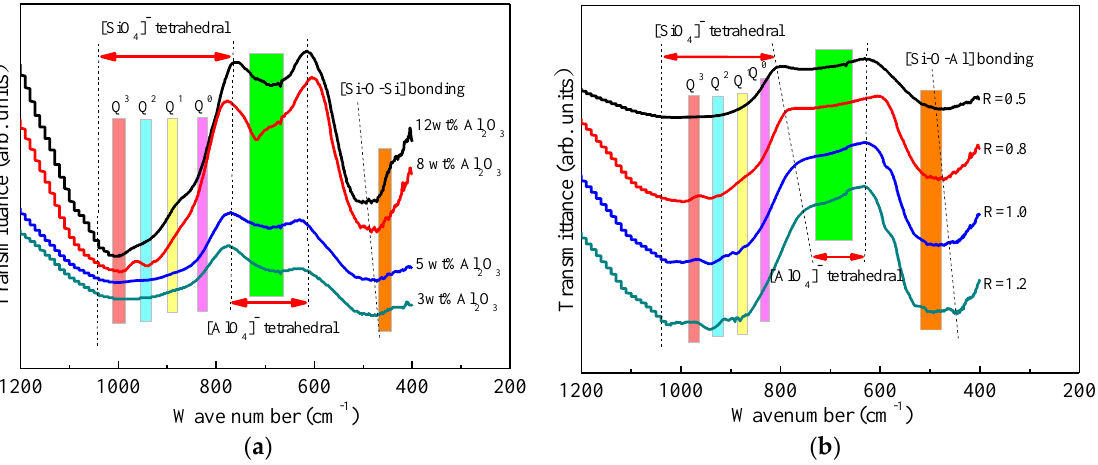
Figure 14. Effect of Al 2 O 3 and basicity on the FTIR transmittance spectra of the CaO – SiO 2 – Al 2 O 3 – 10 wt.% MgO slag ( a ) at a fixed Al 2 O 3 content and ( b ) at different basicities.